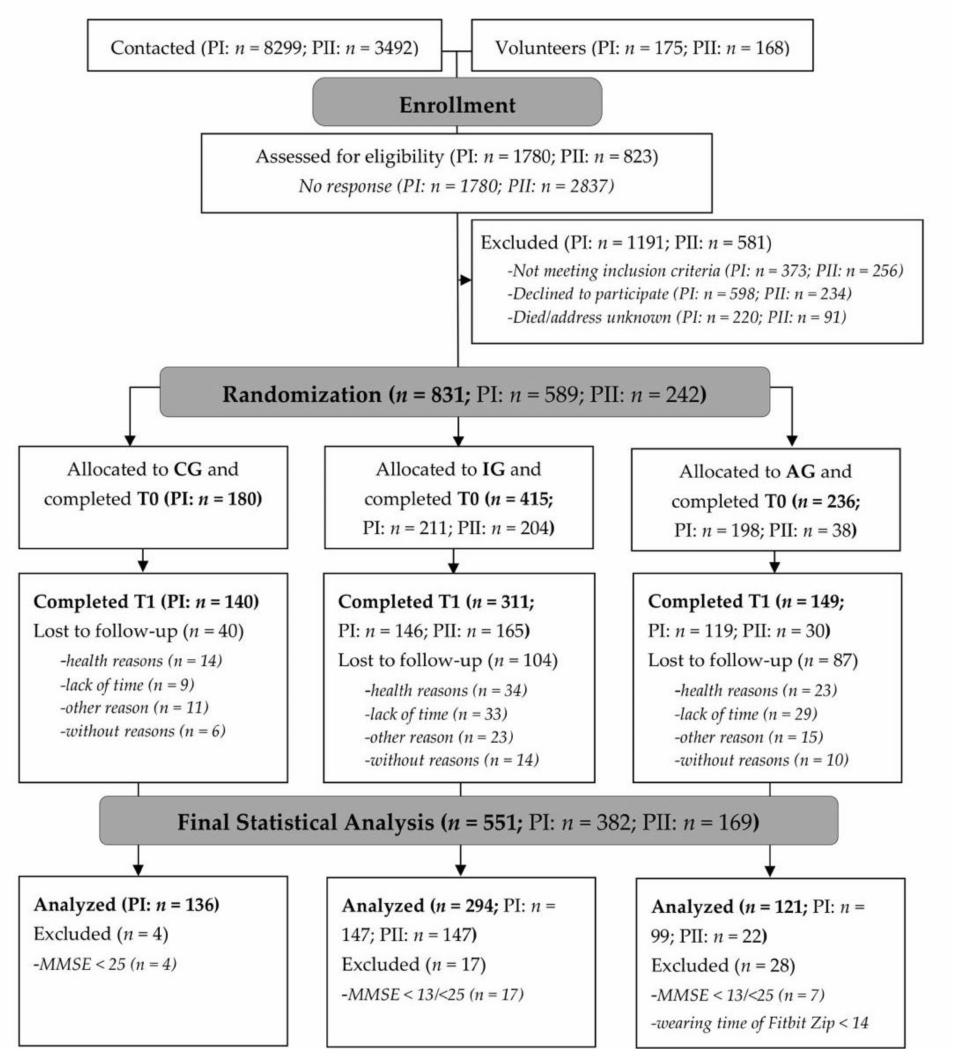
Figure 1. Study flow and randomization procedure of PROMOTE study (PI = PROMOTE I; PII = PROMOTE II). CG = control group; IG = intervention group without activity tracker; AG = activity tracker group receiving the same web-based intervention as the